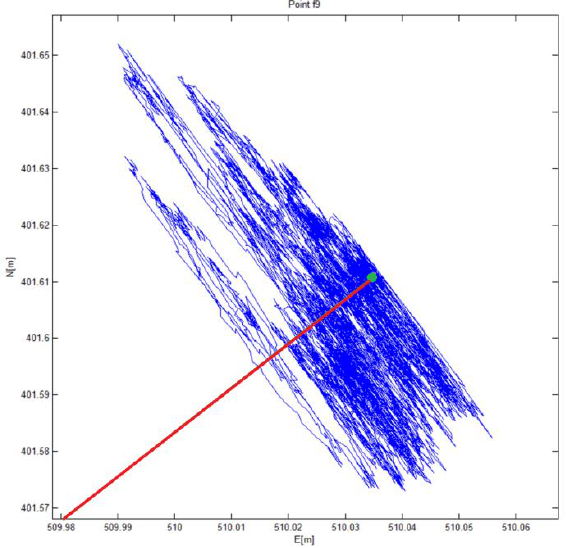
Figure 18. Envelope of the planimetric position obtained by raw observations for point